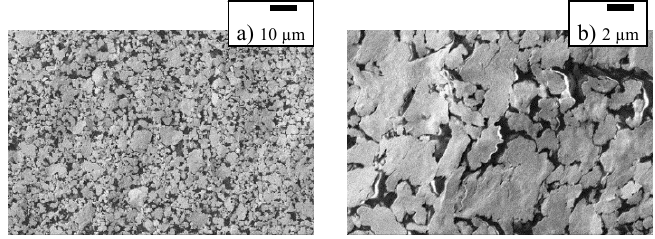
Figure 7. SEM image of a cracked silver nanoparticle film showing many micrometer-scaled silver flakes that can form a conductive path while relaxed: ( a ) scale of 10 µm and ( b ) zoom at 2 µm.